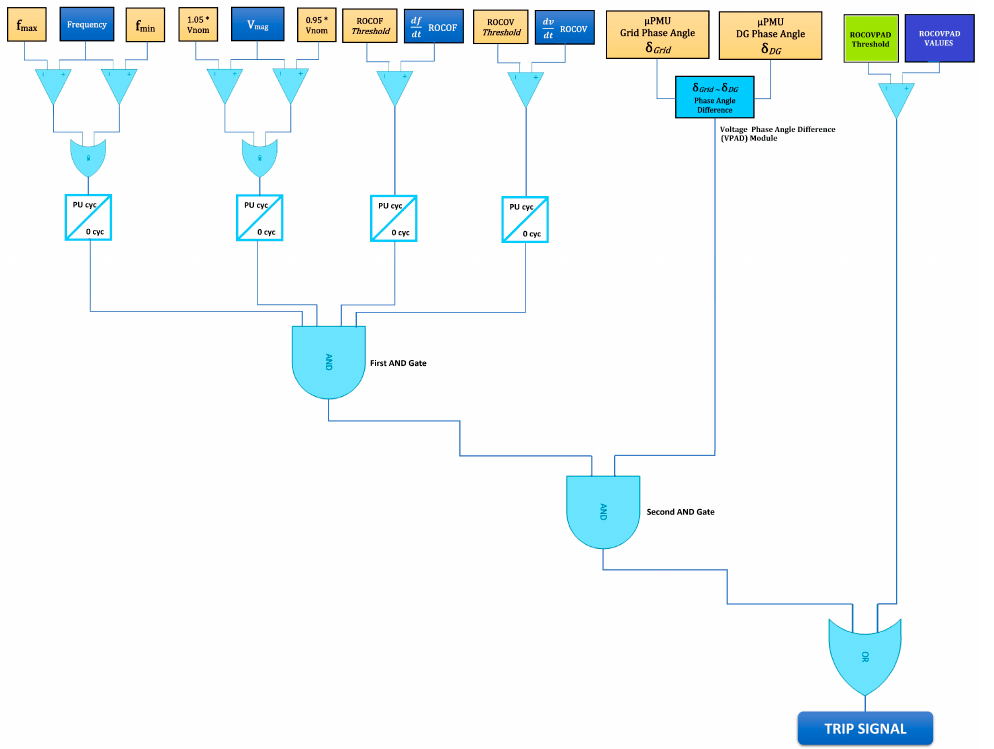
Figure 8. Logic diagram for islanding